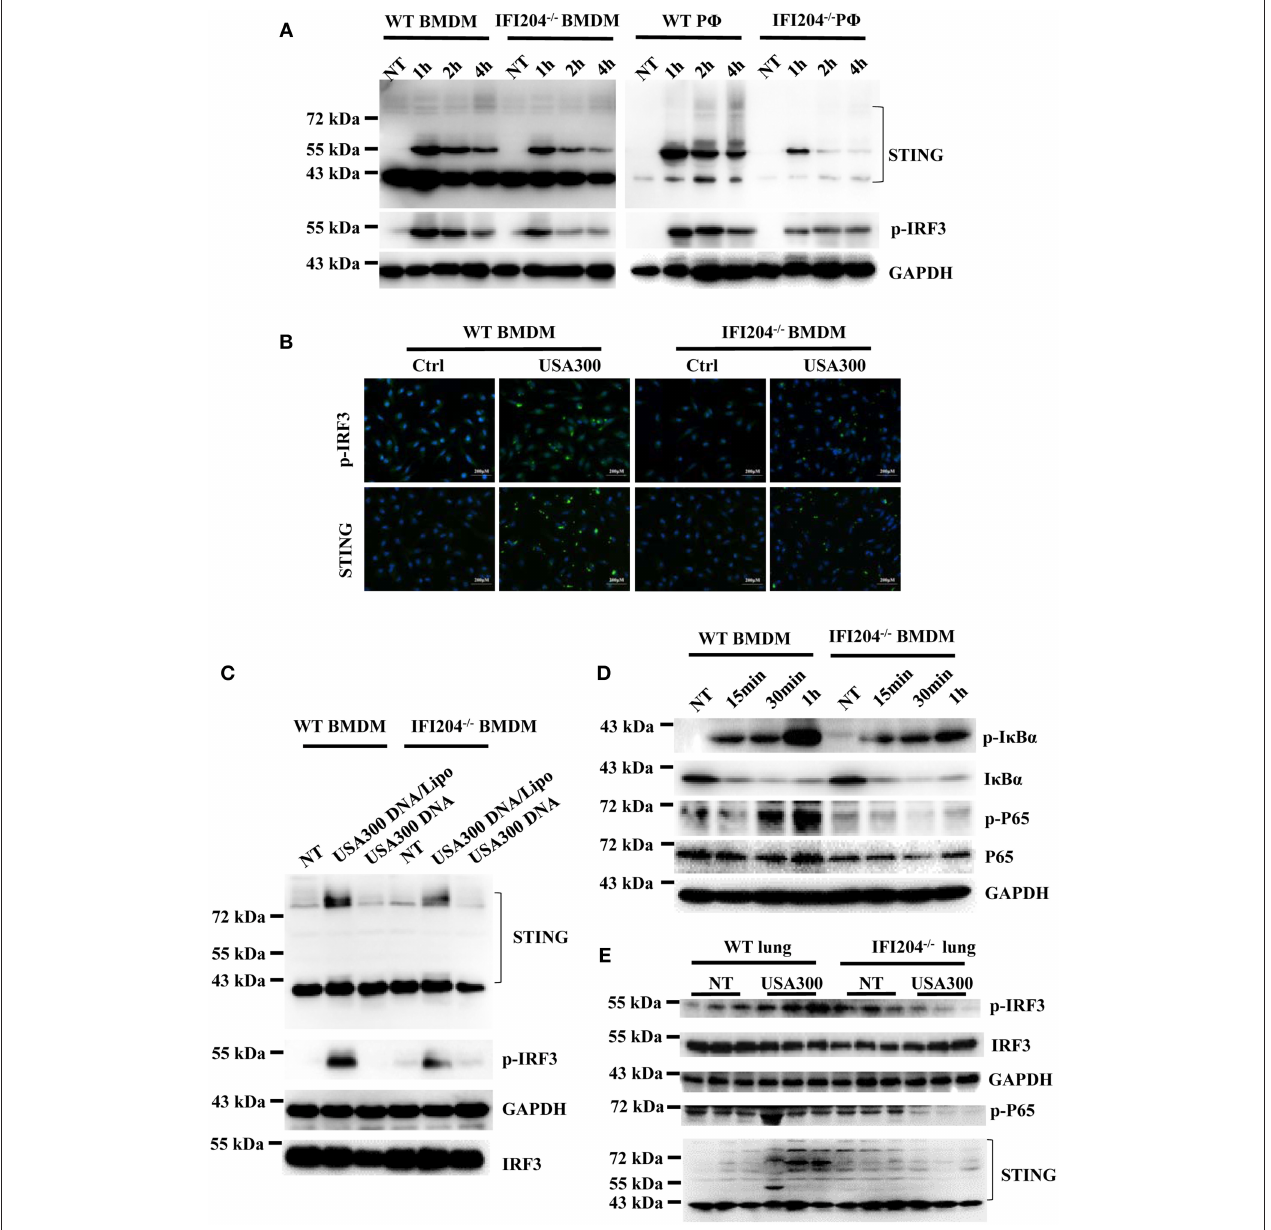
FIGURE 5 | IFI204 deficiency suppresses Staphylococcus -induced activation of STING-IRF3 and NF- κ B signaling. (A) WT and IFI204-deficient BMDM and peritoneal macrophages were untreated (NT) or exposed to Staphylococcus for the indicated times. The cell lysates were examined for expression levels of STING and phospho-IRF3 by Western blotting. The GAPDH served as a loading control. (B) WT and IFI204-deficient BMDM were exposed to Staphylococcus for 1h. STING and phospho-IRF3 were analyzed by immunofluorescence. (C) WT and IFI204-deficient BMDM were incubated with USA300 DNA with or without Lipofectamine 2000 for 1h. STING and phospho-IRF3 were examined by Western blotting. (D) WT and IFI204-deficient BMDM were exposed to Staphylococcus for the indicated times. Phospho-I κ B α , I κ B α , phospho-P65, P65, and GAPDH were examined by Western blotting. (E) WT and IFI204 − / − mice were infected intranasally with 1 × 10 8 CFU of Staphylococcus . Lung tissues were collected and homogenized at 24h postinfection, and then immunoblotting for Sting and phospho-IRF3, IRF3, GAPDH, P65, and